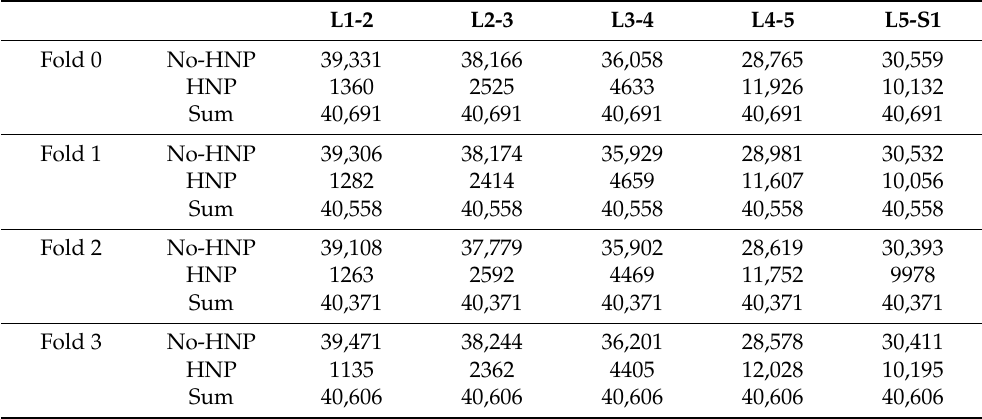
Table 1. Each lumbar level distribution of lumbar herniated nucleus pulposus according to each fold in the training